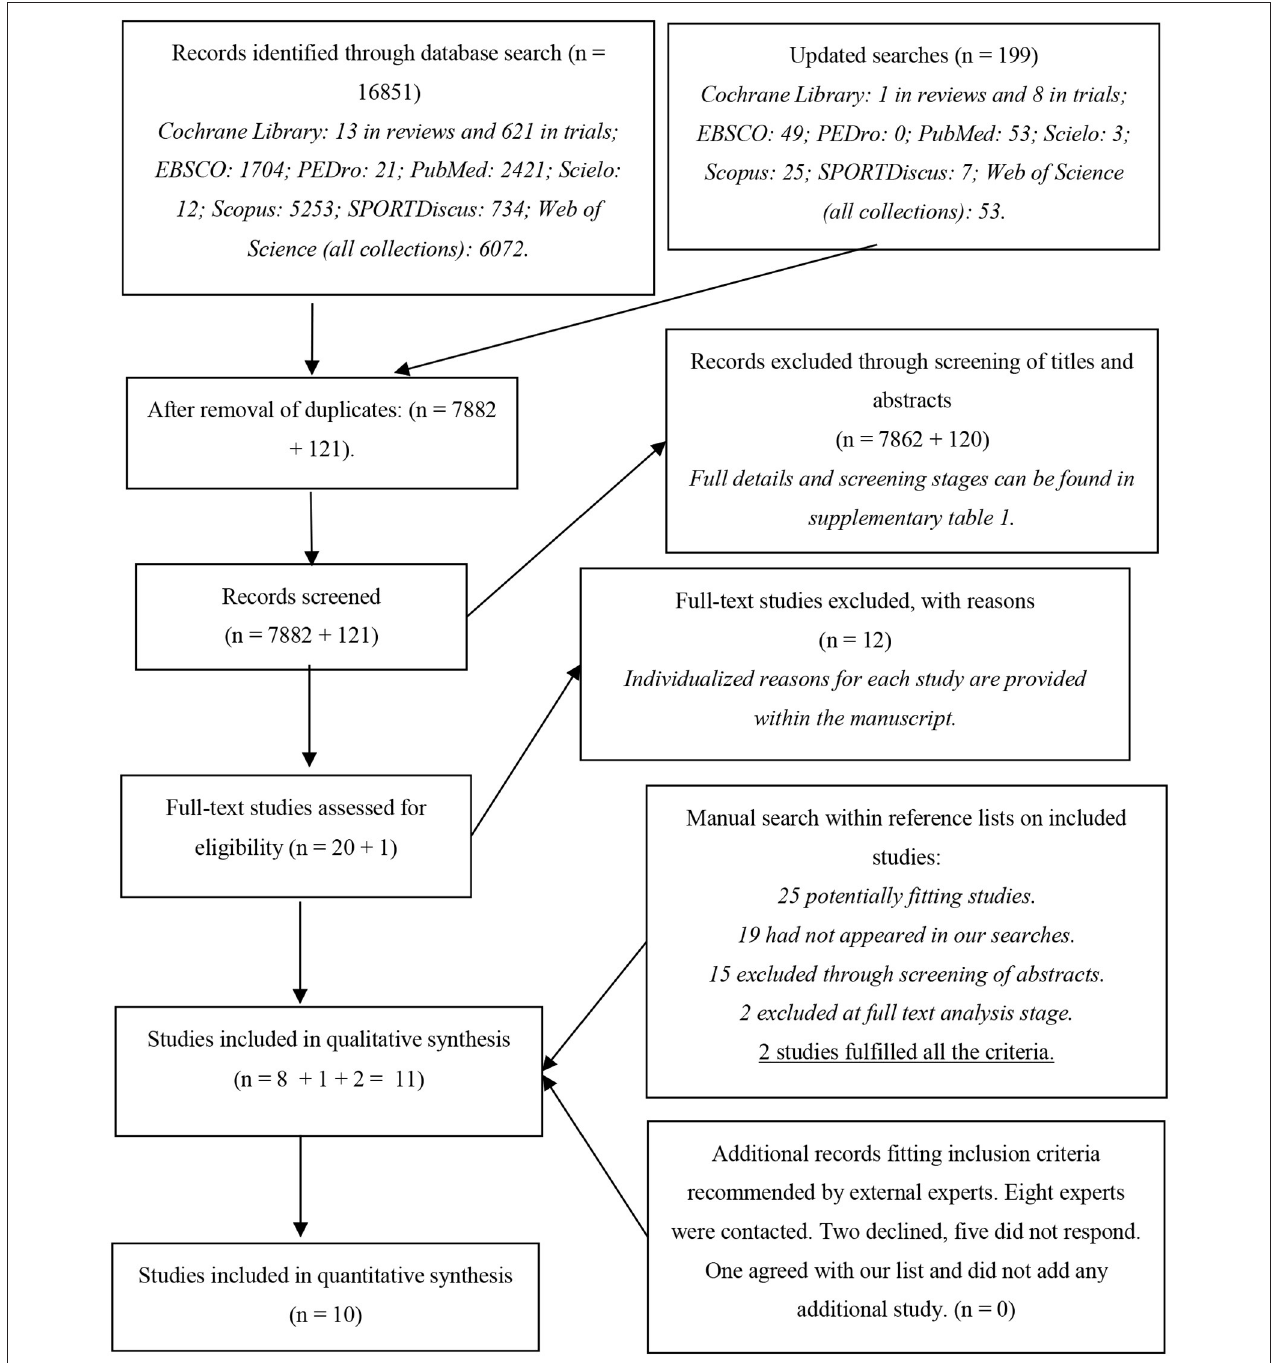
FIGURE 1 | Flowchart describing the study selection